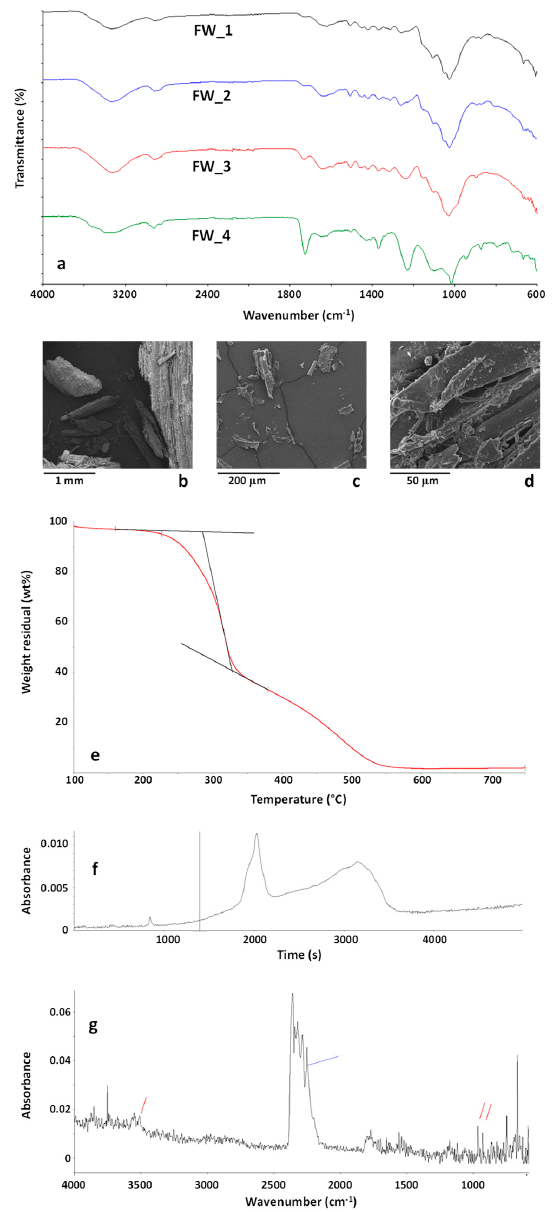
Figure 5. FTIR spectra of FW particles ( a ); SEM images ( b – d ) of the FW sample. TG curve of the sample FW in the temperature range 100–750 ◦ C ( e ). Gram-Schmidt profile ( f ) and FTIR spectrum ( g ) of the evolved gases from the sample FW at 260 ◦ C during TG